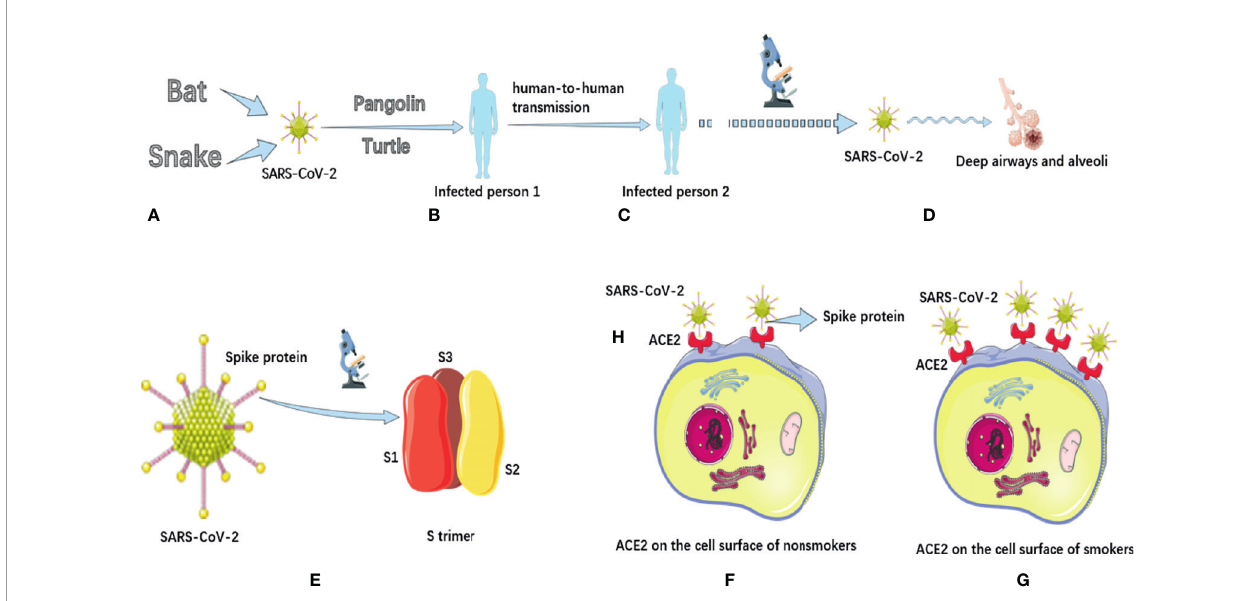
FIGURE 1 | The potential animal origin, transmission characteristics, structure and pathogenic mechanisms of SARS-CoV-2. (A) Some studies have suggested that COVID-19 may have originated in bats or snakes. (B) Turtles and pangolins may be potential intermediate hosts for transmission of COVID-19 to humans. (C) COVID-19 has the potential for sustained human-to-human transmission and has pandemic characteristics. (D) . In terms of mechanism of action, COVID-19 mainly causes in fl ammatory responses characterized by deep airway and alveolar injury. (E) There are a large number of spike proteins on the surface of SARS-CoV- 2. The spike protein on the surface of SARS-COV-2 is a trimer composed of three subunits with a triangular section. (F) Distribution of ACE2 on the cell surface of nonsmokers. (G) The distribution of ACE2 on the cell surface of smokers, and its expression is signi fi cantly up-regulated. (H) The binding receptor protein of spike protein of SARS-CoV-2 in human body is ACE2 protein. The SARS-CoV-2 has a high af fi nity for human